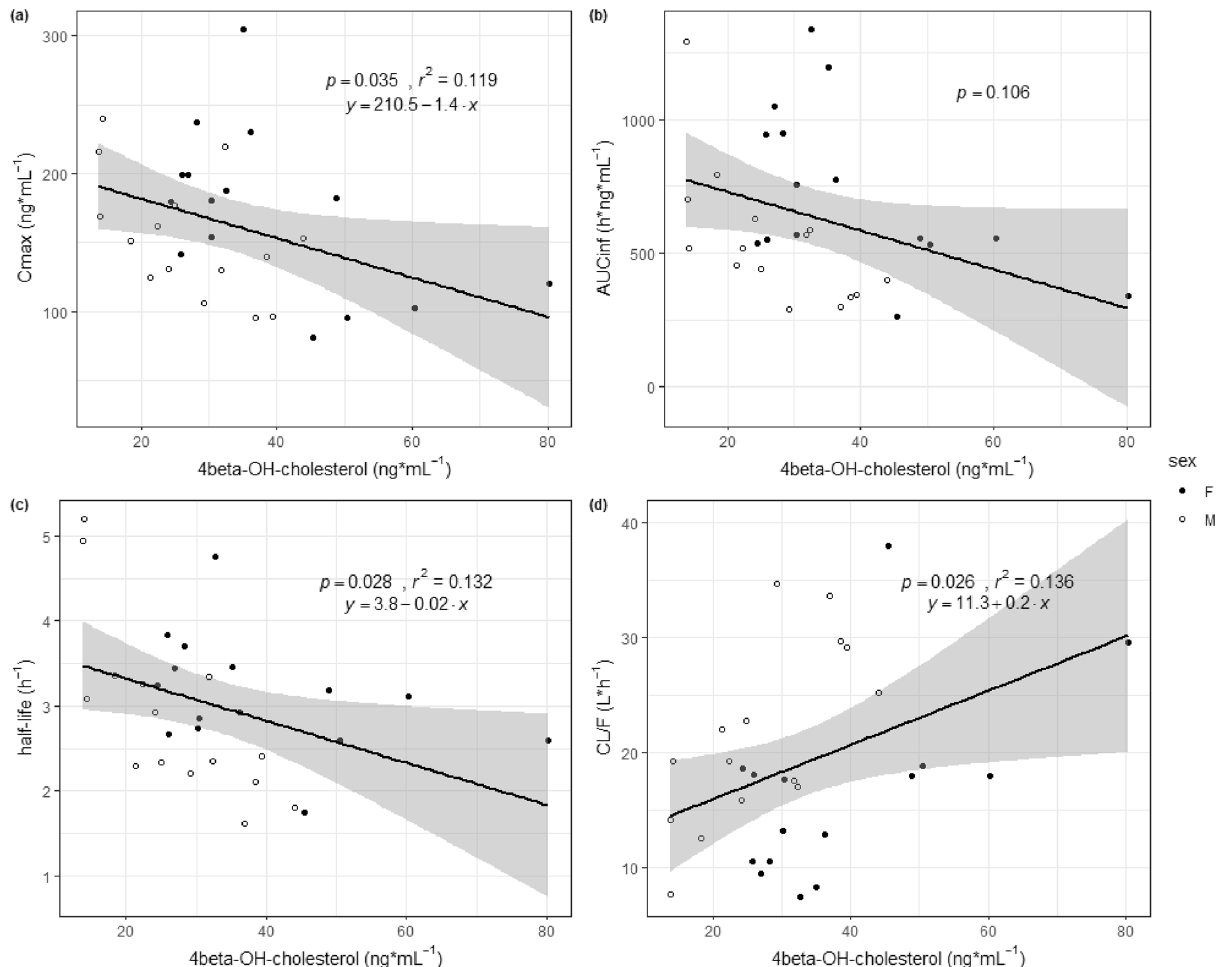
Figure 4. Relationship between pharmacokinetic parameters and CYP3A activity. The relationship between CYP3A activity (4beta-OH cholesterol) and ( a ) C max , ( b ) AUC inf , ( c ) half-life, and ( d )